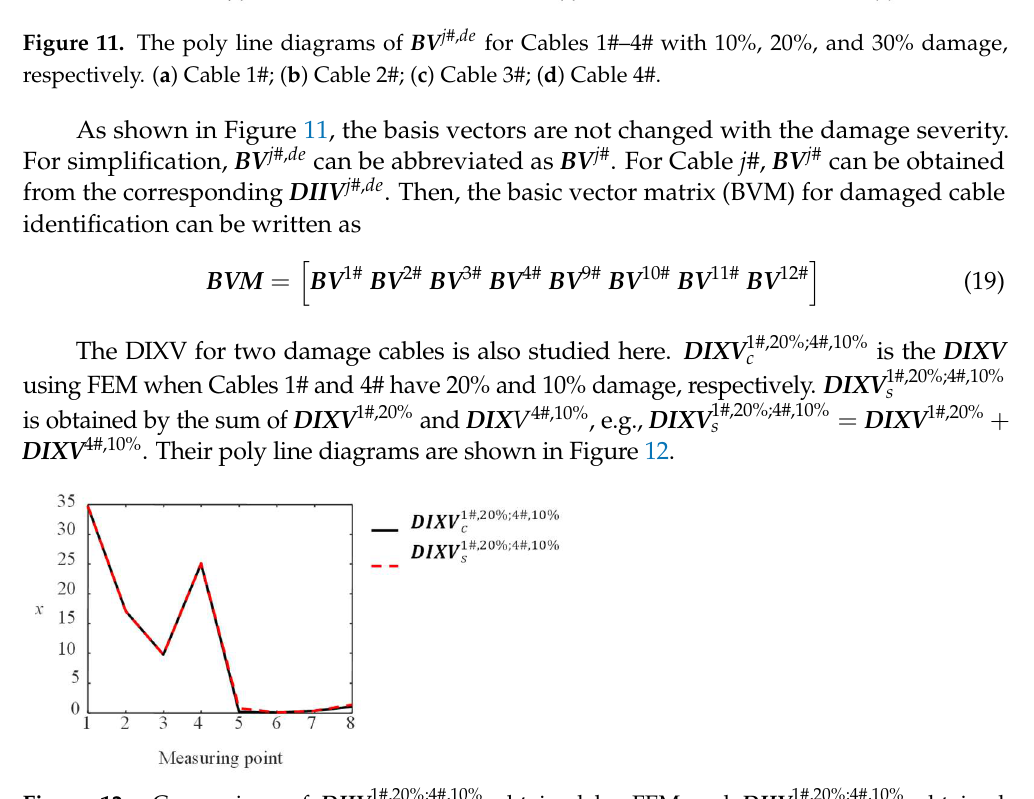
Table 2. The hypothetical damage scenarios.